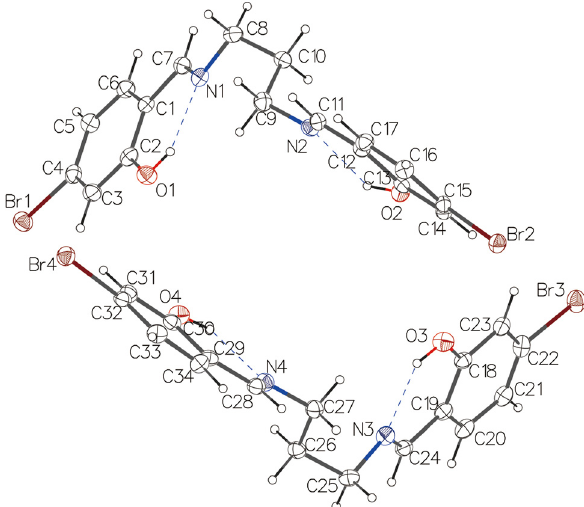
Table  : Data collection and